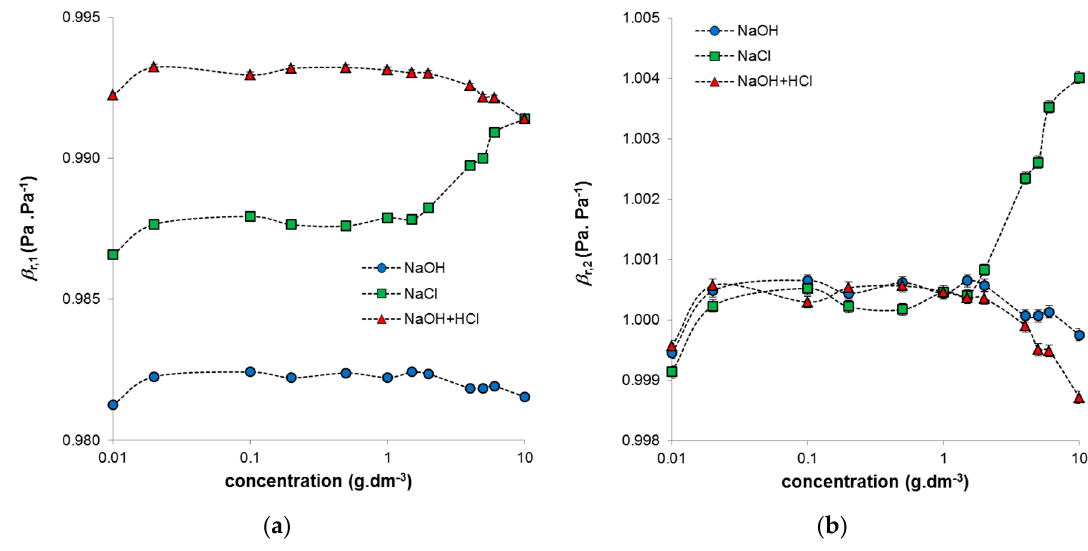
Figure 4. Obtained compressibility of prepared humic sols normalized on water ( a ) and the surrounding medium ( b ) in dependence on concentration of humic acids.